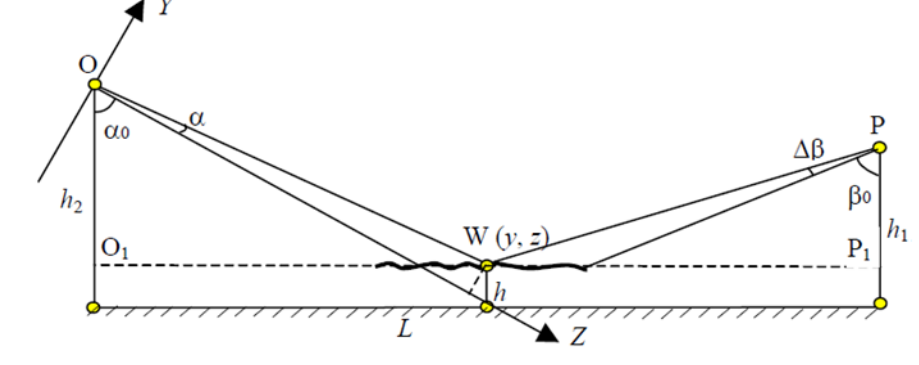
Figure 7. Mechanism of laser triangulation scanning.